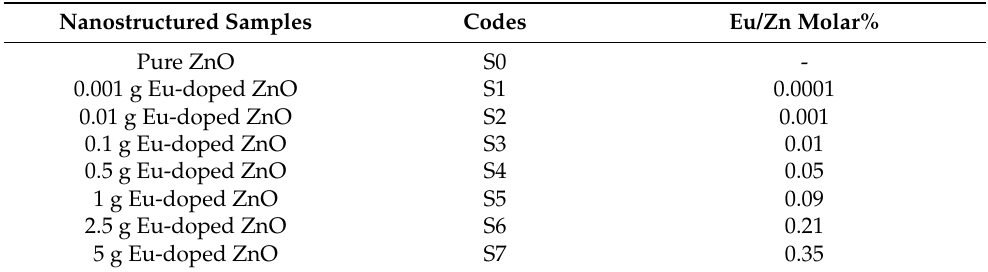
Table 1. Sample code of pure and doped ZnO nanostructures with different Eu 2 O 3